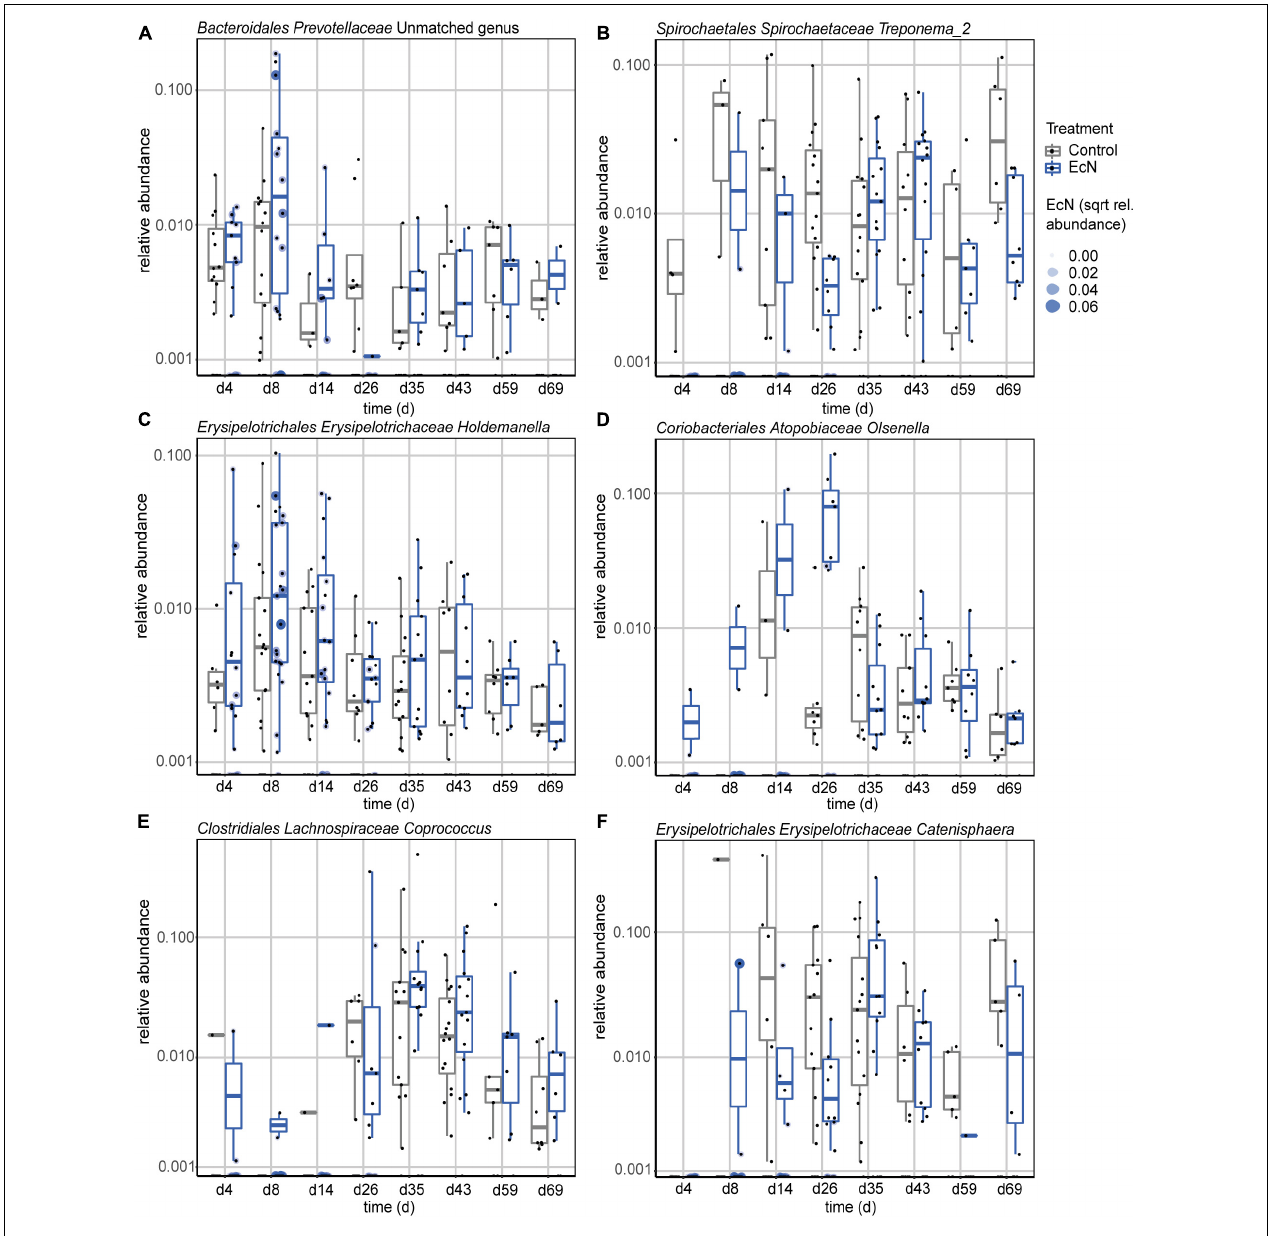
FIGURE 4 | Relative abundances of differentially abundant genera in feces during the complete study period, including an unclassified genus in the family of Prevotellaceae (A) , Treponema_2 (B) , Holdemanella (C) , Olsenella (D) , Coprococcus (E) , and Catenisphaera (F) . Shown genera resulted from comparing EcN-treated animals to control animals using a GAMLSS model. Probiotic intervention was used as the main variable for comparison and day of study and department were used as adjusting variables. Ear tag was used as identifier and “fdr” was chosen as the method for multiple testing adjustment ( p .adjust <